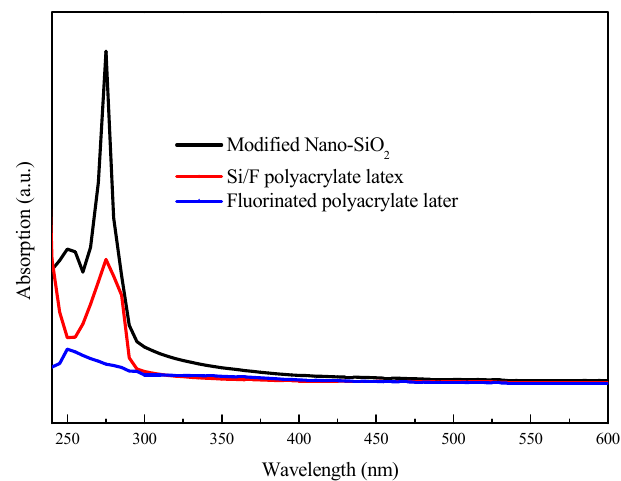
Figure 6. The UV-Vis absorption spectra of modified Nano-SiO 2 , fluorinated polyacrylate emulsion film, and Si/F polyacrylate emulsion film.